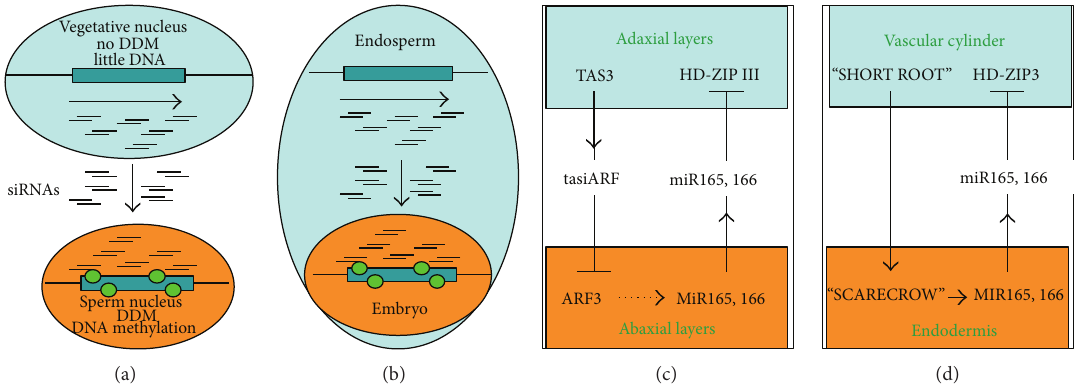
F 4: Gene regulation by sRNA movement. (a) Release of siRNAs from transposons in the vegetative nucleus. ose are transported to the sperm nucleus enforcing transposon silencing there. (b) A similar mechanism leads to siRNAs production in the endosperm and their role in embryo chromatin silencing. (c) Control of adaxial and abaxial identity through ta-siRNA and miRNA gradients. (d) Control of xylem patterning through miRNA gradients [63].